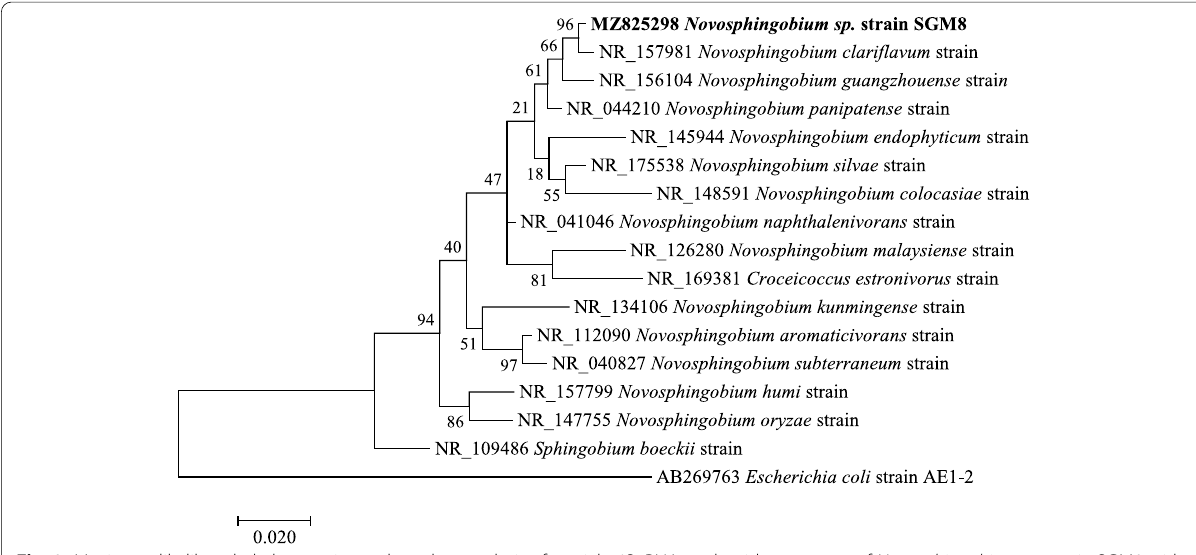
Fig. 2 Maximum likelihood phylogenetic tree based on analysis of partial 16S rRNA nucleotide sequence of Novosphingobium sp. strain SGM8 with reference sequences selected from the NCBI . Escherichia coli strain AE1-2 was used as an outgroup